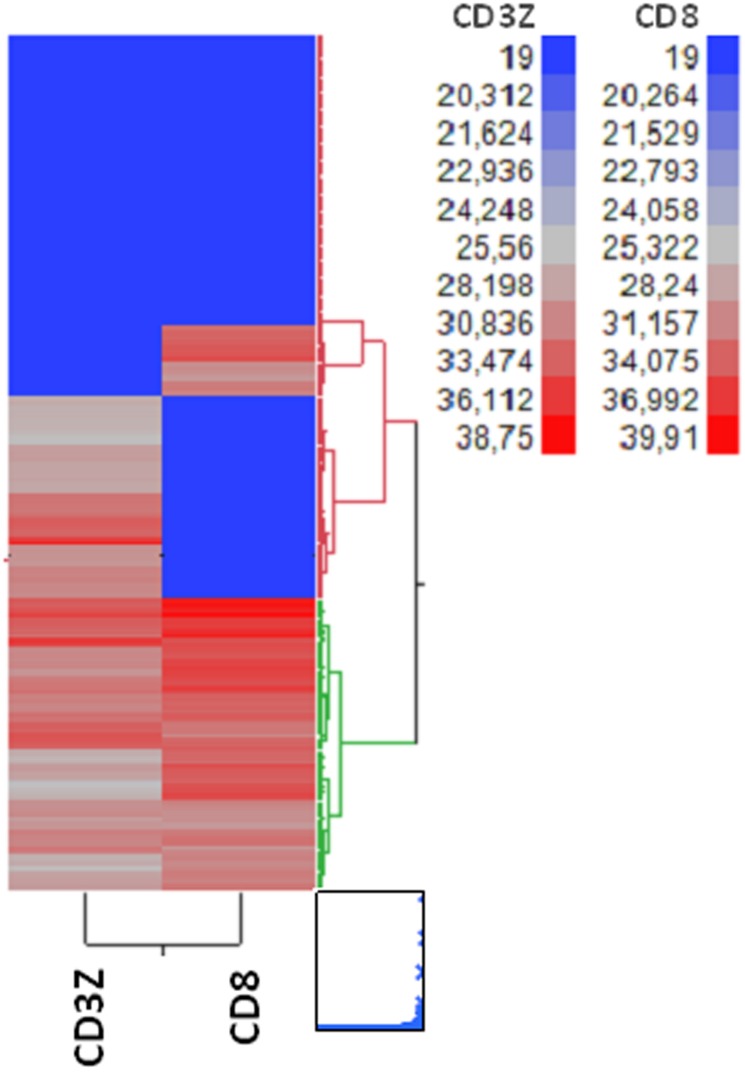
mRNA-based 2-cluster tumour Immune Score heatmap (mIS).